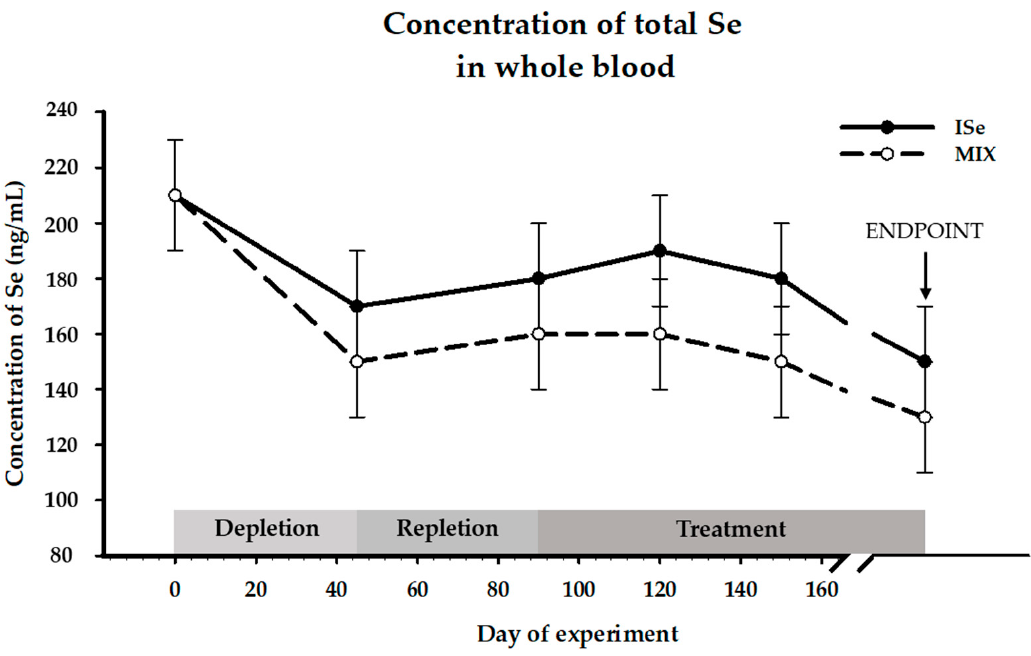
Figure 2. Effect of treatment (form of Se) on concentrations of Se in whole blood (ppm; LS Mean ± SEM) of Se in cows supplemented with either ISe (Sodium selenite; n = 5) or a 1:1 combination (MIX) of ISe and OSe (Sel-Plex; n = 5). Data were analyzed as an ANOVA with repeated measures. Whole blood Se was not affected by treatment ( p = 0.2393) but was affected by time ( p < 0.0001).